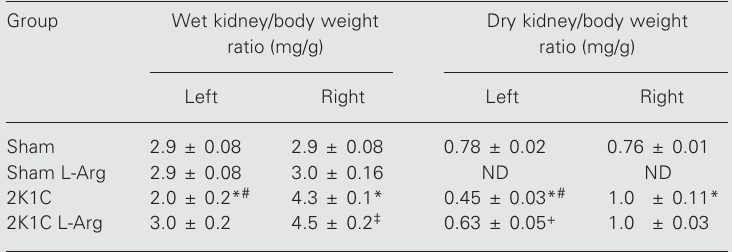
Table 2. Wet and dry kidney/body weight ratios of clipped (left) and non-clipped (right) kidneys of sham and two-kidney, one-clip (2K1C) renovascular hypertensive rats treated or not with L-arginine